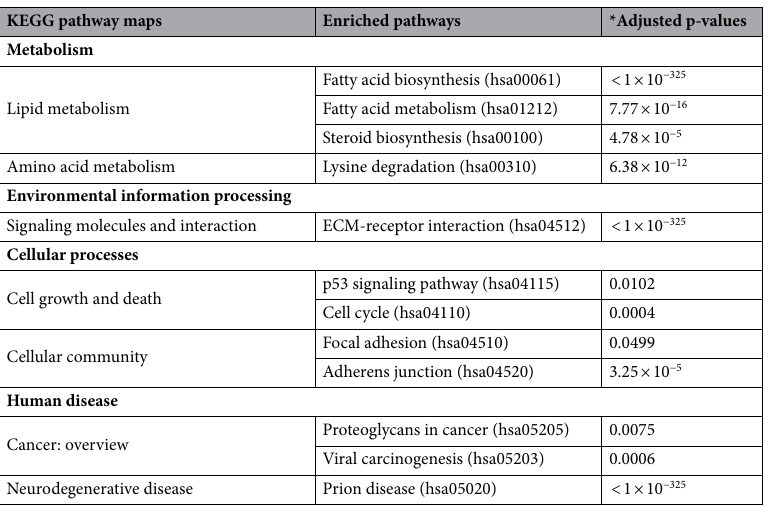
Table 4. Enriched pathways: results using the DIANA-mirPath v3.0 software. *Adjusted p-values were obtained by using the Benjamini–Hochberg method.